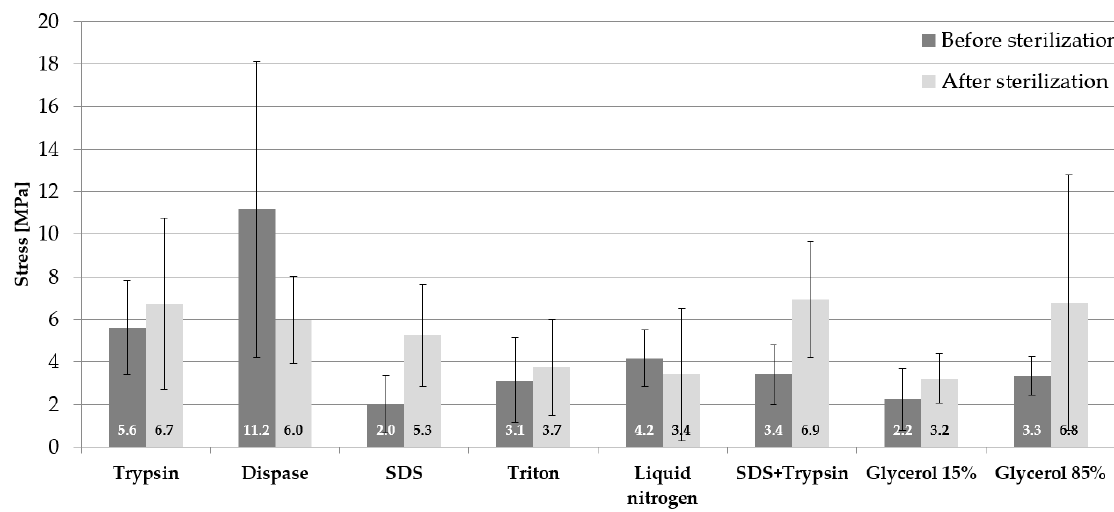
Figure 3. Mean values of maximum stress.